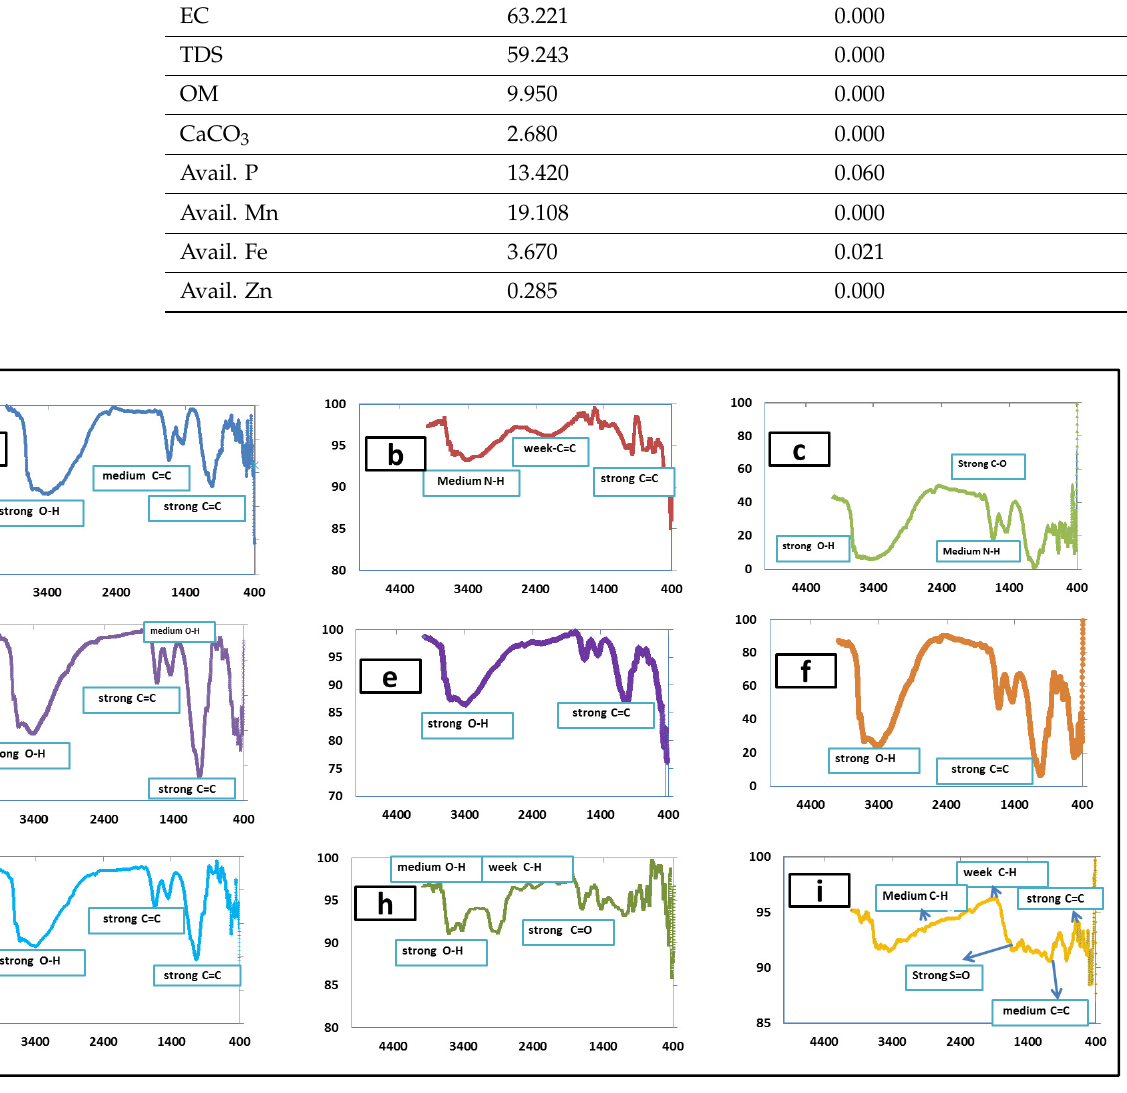
Figure 1. FTIR spectra of biochar, microplastic and all treated soils. ( a ) Control; ( b ) 1.5% MP; ( c ) 7.5% MP; ( d ) 15% MP; ( e ) 1.5% MP +BC; ( f ) 7.5% MP + BC; ( g ) 15% MP + BC; ( h ) microplastic; ( i